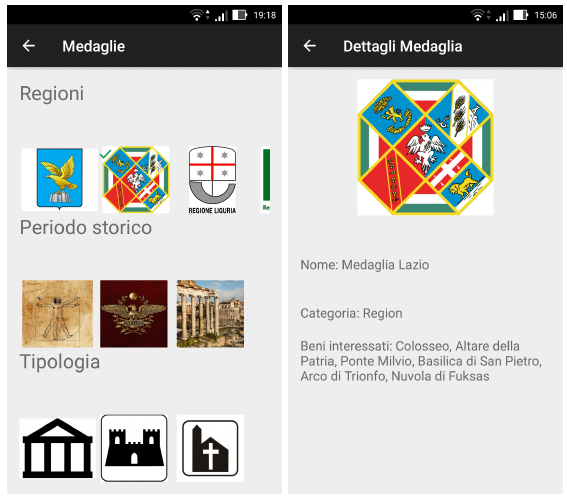
Figure 3. Visit them all